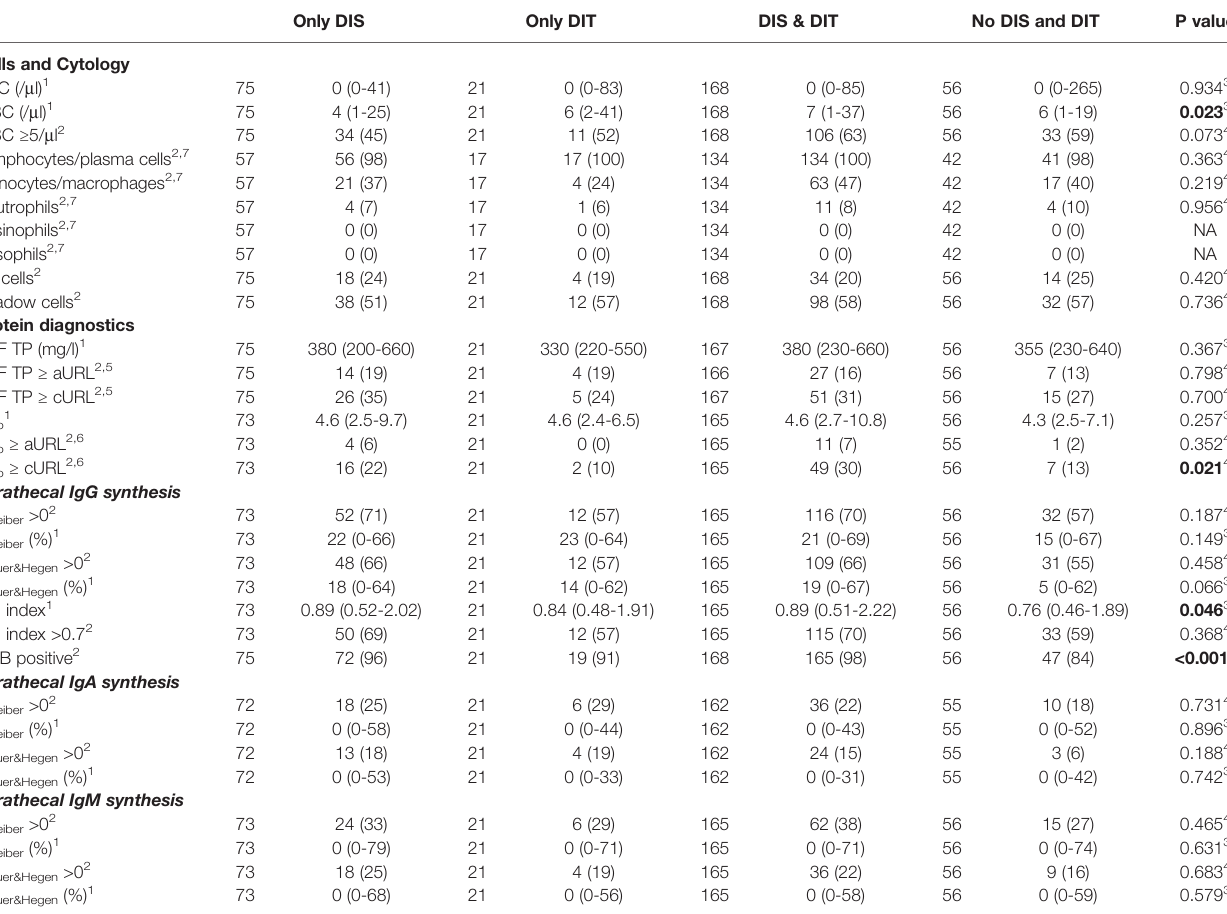
TABLE 3 | Cerebrospinal fl uid fi ndings in patients with a fi rst clinical attack according to MRI criteria of DIS and DIT. Only DIS Only DIT DIS & DIT No DIS and DIT P value Cells and Cytology RBC (/ m l)